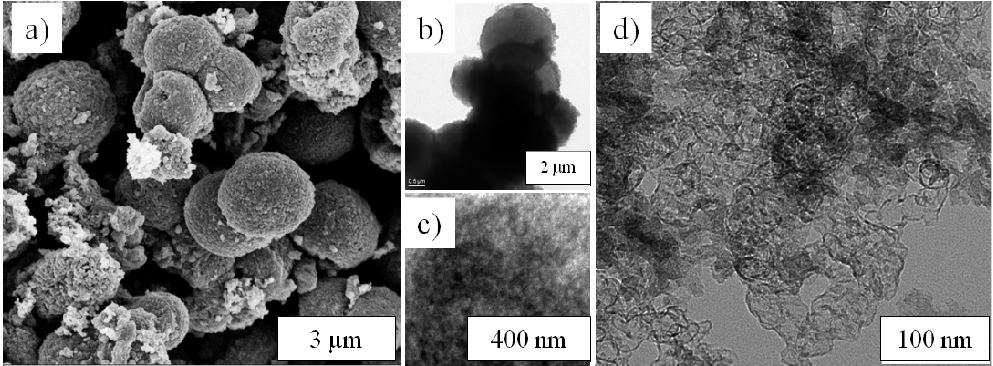
Figure 5. ( a ) SEM and ( b – d ) TEM images of the carbon coating from LFP250-1-700 after removing LiFePO by HCl (37%); ( c ) magnified TEM image; ( d ) TEM image of a broken 4 part of the pure